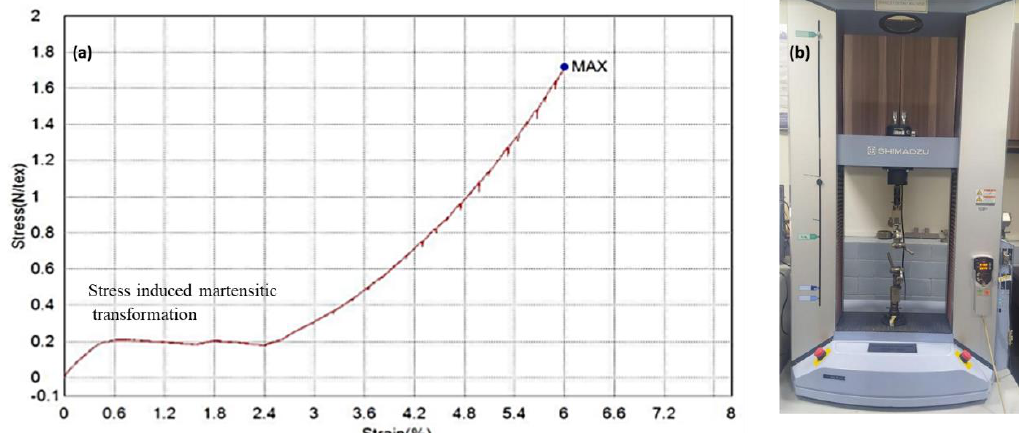
Figure 9. Results of Charpy impact test indicating impact strength for GFRP, SS/GFRP, and SMA/GFRP composites: ( a ) set A, with dimensions of 6 mm × 6 mm × 44 mm; ( b ) set B, with dimen- sions of 6 mm x 6 mm x 57 mm. At a p value of 0.05, the impact strength with the notch is signifi- cantly different for all samples. However, the difference in impact strength with and without the notch is not significant. * symbolizes the significant difference and # symbolizes the insignificant difference.